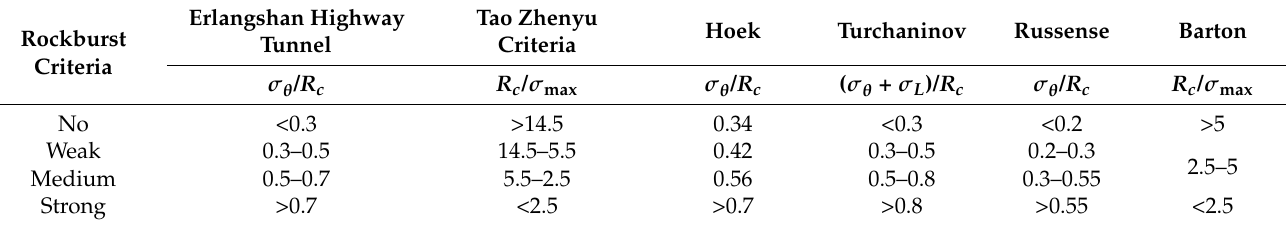
Table 1. Stress criteria for rockburst prediction.